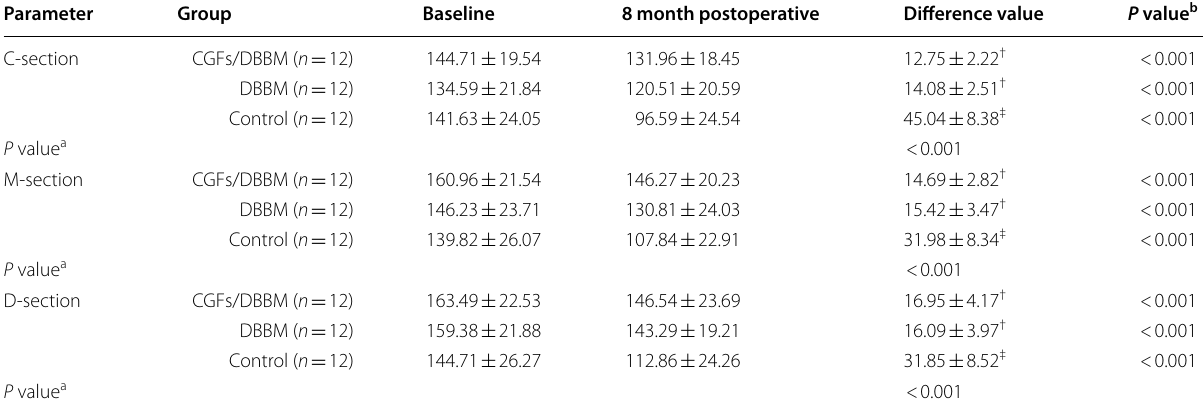
Table 2 Between and within‑group comparison of alveolar bone area in C‑, M‑, and D‑sections for the three groups. (mm 2 , Mean SD) ±